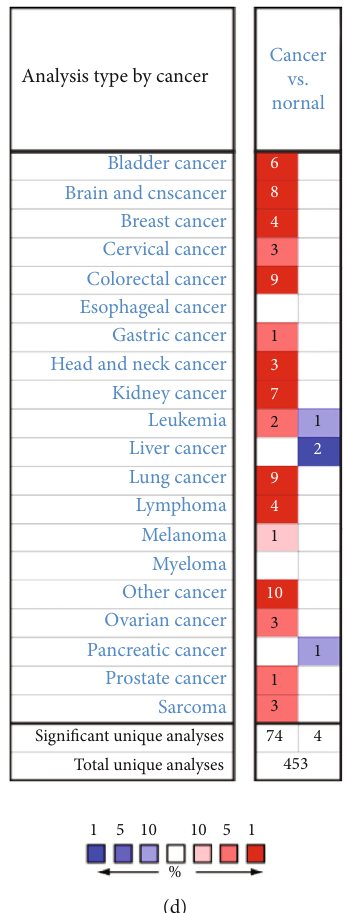
Figure 5: SHMT2 expression level (a) mRNA expression of SHMT2 in LUAD. The mRNA expression of SHMT2 is higher in tumor but lower in normal based on TCGA samples; (b) protein expression of SHMT2 in LUAD. The protein expression of SHMT2 is higher in tumor while lower in normal based on CPTAC samples; (c) the mRNA expression level of SHMT2 in various cancer. Color images are available online. Fold change = 2 and P value = 0.01; (d) SHMT2 di ff erent expression between tumor and adjacent normal tissue. ∗ P < 0 : 05 , ∗∗ P < 0 : 01 , ∗∗∗ P < 0 : 001